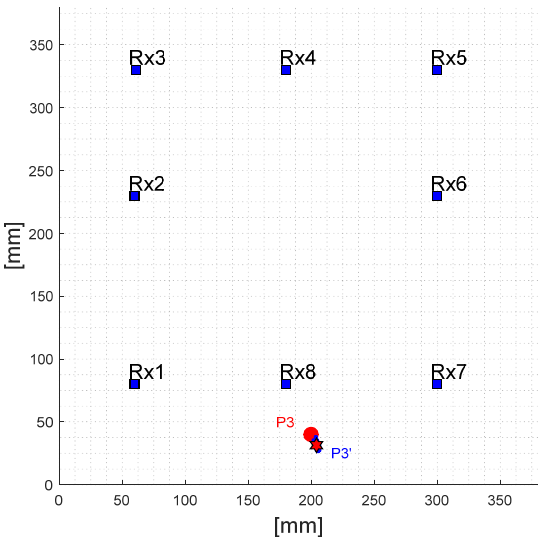
Figure 13. Position of impact P3 (red circle) outside the ROI. The detected impact position P3 ′ (red star) with coordinates x p = 205 mm, y p = 32 mm was obtained by processing signals acquired by all eight sensors.